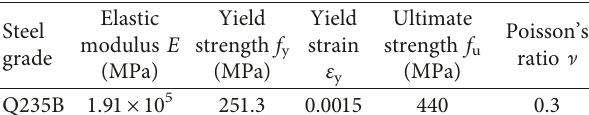
Table 2: Material properties of Q235B.